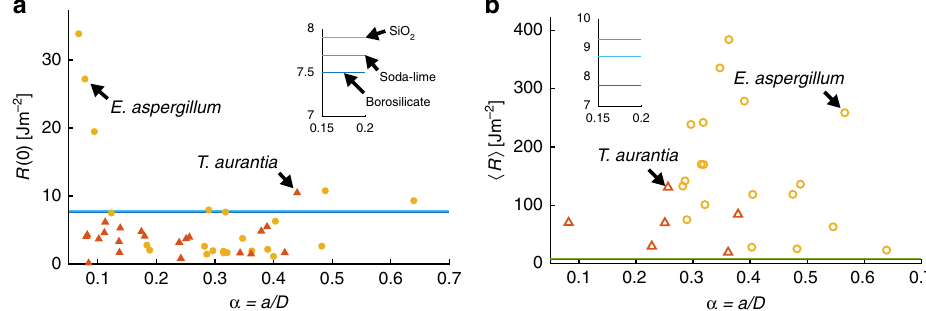
Fig. 7 Crack growth resistance of Ea . and Ta . spicules. a Fracture initiation toughness, R (0), of 22 Ea . spicules (yellow circles) and 21 Ta . spicules (red triangles) versus dimensionless notch length, α = a ∕ D . Reference lines are shown corresponding to the fracture initiation toughnesses of three types of synthetic glass measured by 67 . The inset shows a closer view of these three values. b Average crack growth resistance, 〈 R 〉 , of 19 Ea . spicules (hollow yellow circles) and 6 Ta . spicules (hollow red triangles) versus α . Reference lines are given that correspond to the average crack growth resistance of the three types of synthetic glass shown in a . We computed the value of 〈 R 〉 from the measurements of the work of fracture provided by 67 . The inset in b shows a closer view of these three